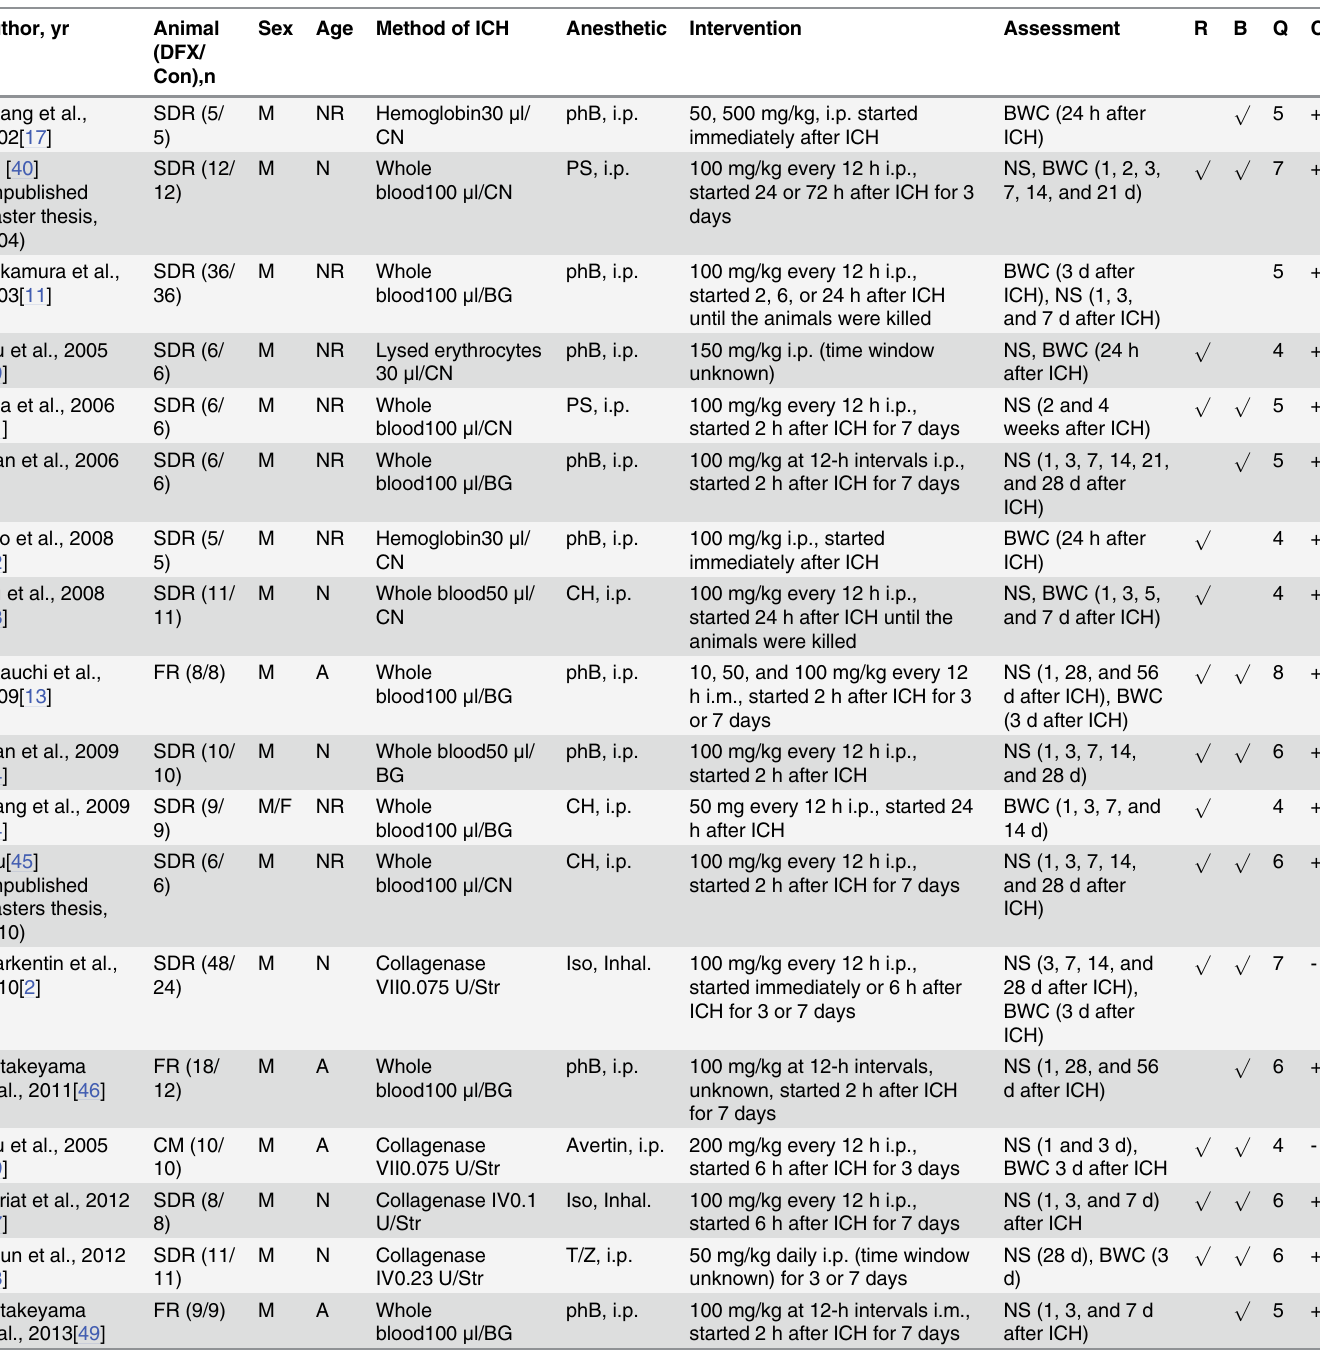
Table 1. Design characteristics of included